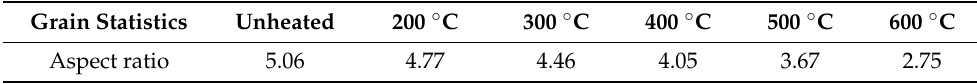
Figure 8. EBSD maps of the Ti-6Al-4V alloy after LPBF in the case of ( a ) unheated, ( b ) 200 °C, ( c ) 300 °C, ( d ) 400 °C, ( e ) 500 °C, and ( f ) 600 °C. Table 4. The aspect ratios at different powder bed